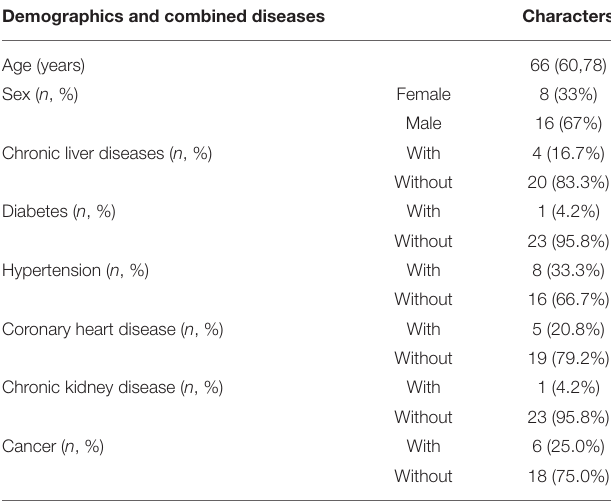
TABLE 1 | Clinical information of patients with COVID-19 ( N = 24).